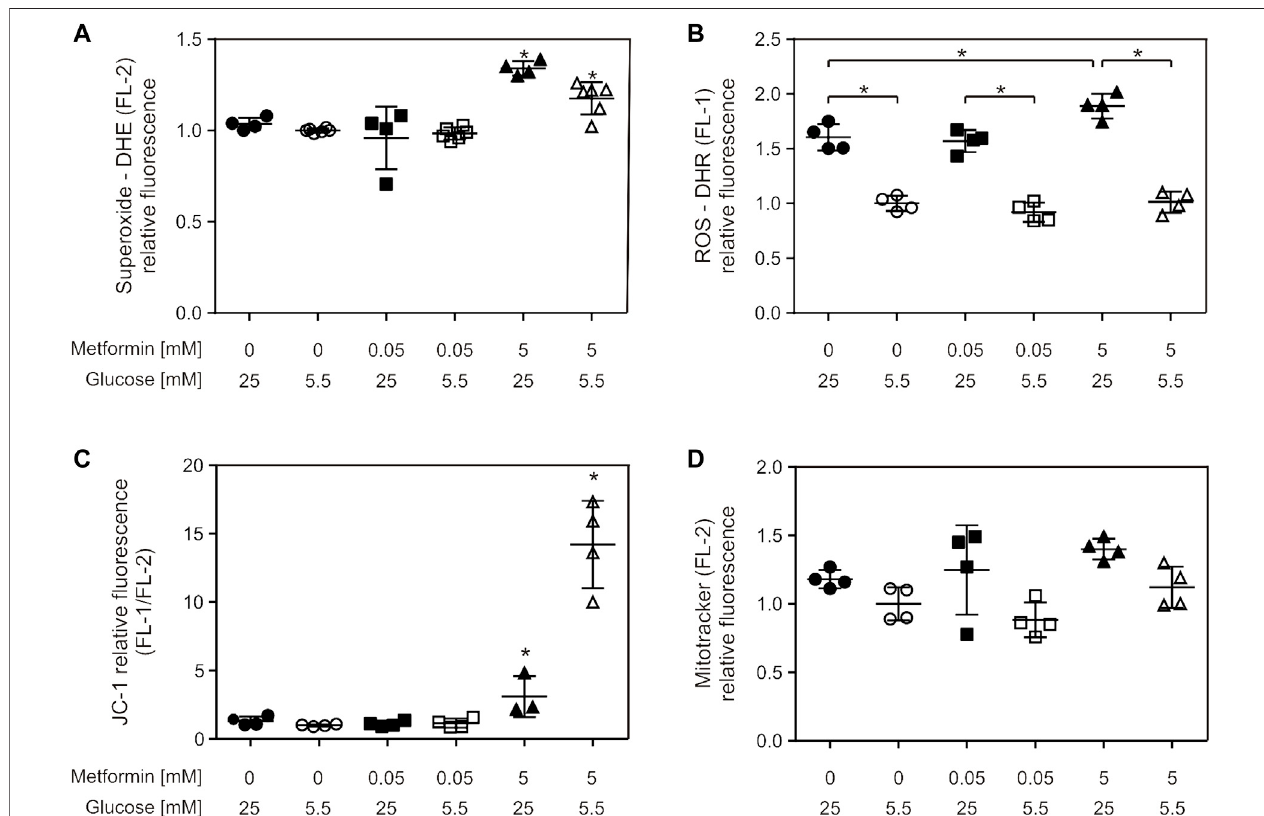
FIGURE 4 | Suprapharmacological, but not therapeutic, metformin concentration caused increased total ROS and superoxide production and mitochondrial membrane depolarization. C2C12 cells were treated with 50 µM or 5 mM metformin for 24 h, and superoxide (A) , ROS (B) , mitochondrial membrane potential (C) and mitochondrialcontent (D) weremeasuredby fl owcytometryusingappropriate fl uorophores.Allthedatapointsfromtwoindependentexperimentsdoneinduplicateare presented as scatter plots, with mean ± SD, * p < 0.05.